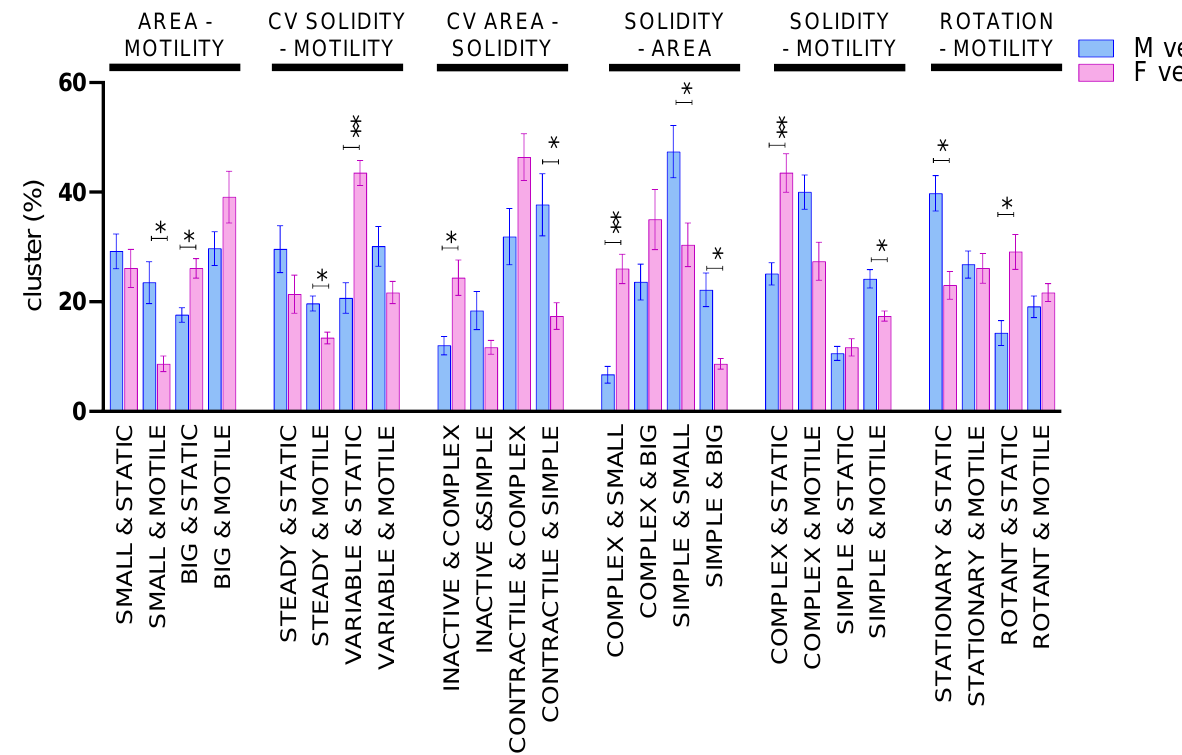
Figure 3. Morpho-functional biparametric analysis of male and female microglia. Biparametric analysis is represented as a histogram of the median ± SEM of the subpopulation percentage obtained in 3 different experiments. The two parameters obtained to generate the clusters are reported on the top of the graph. * p < 0.05, ** p < 0.01 calculated by t -test versus vehicle.